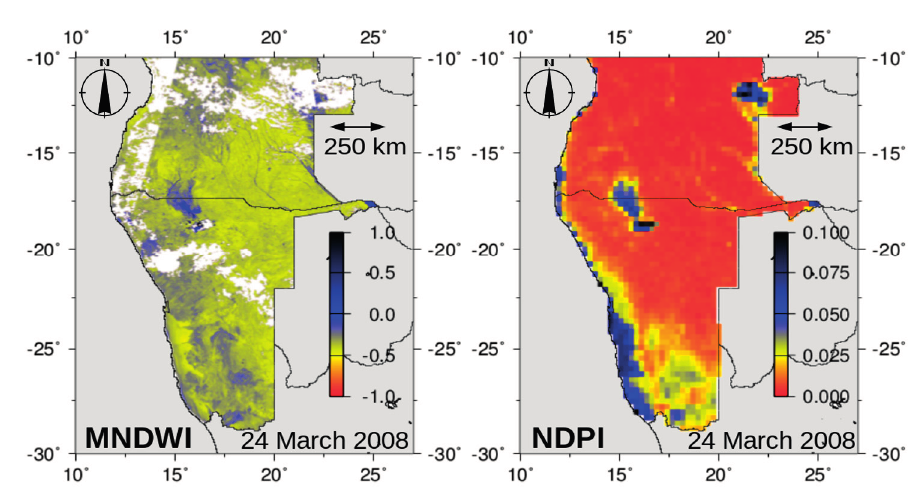
Figure 4. Comparison of the spatial patterns of MNDWI and NDPI in the rainy season. Areas with high MNDWI (such as seasonal wetlands, rivers, and the Etosha Pan) have high NDPI and areas with low MNDWI have low NDPI, except for the Namib Desert along the western